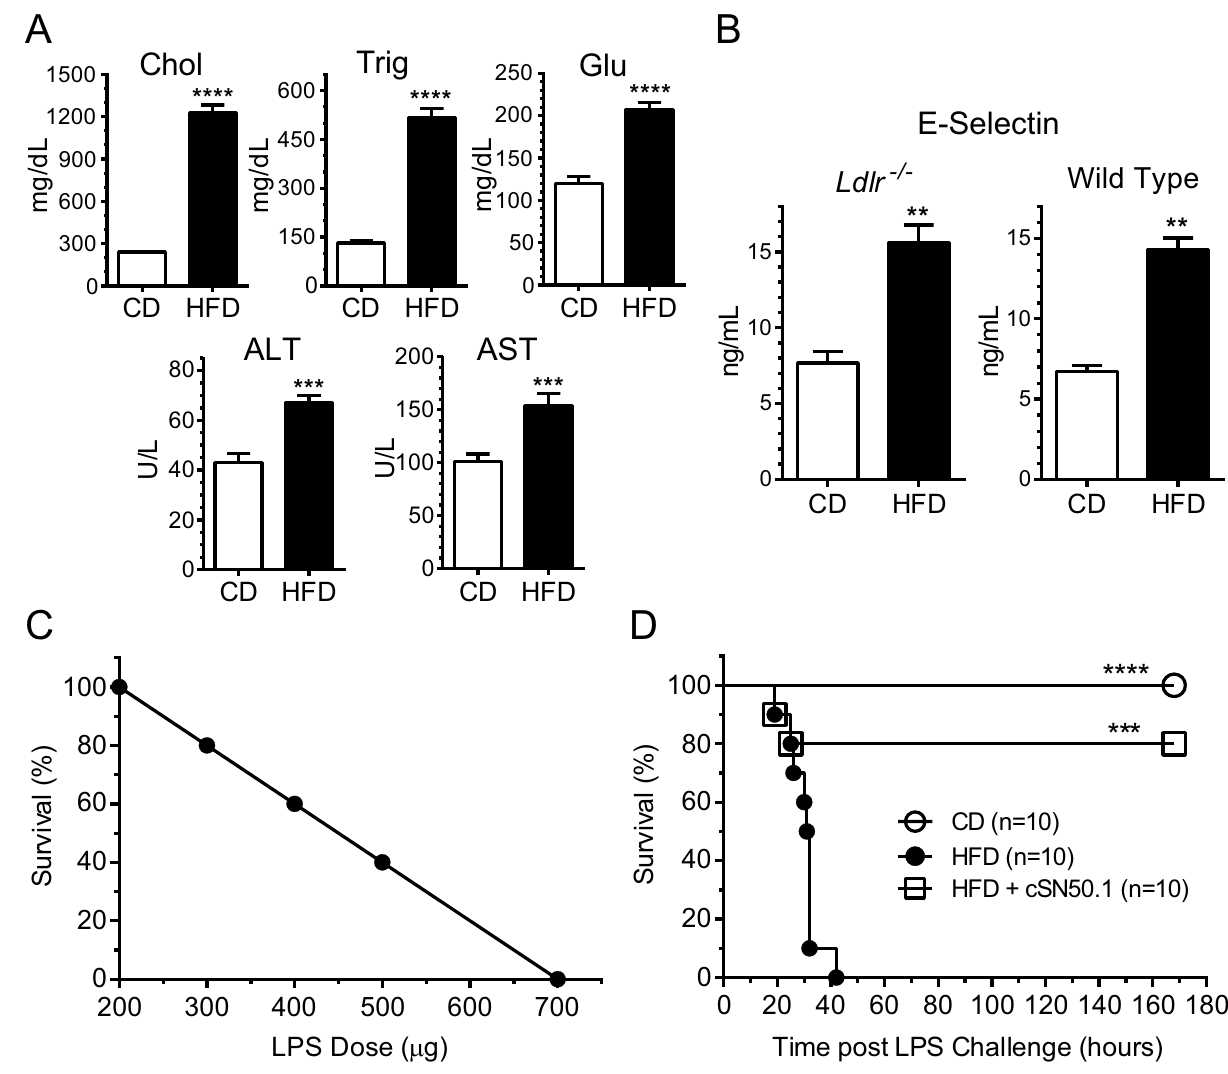
Figure 1. HFD-induced hyperlipidemia and hyperglycemia contribute to microvascular endothelial injury and hypersensitivity to LPS. ( A , B ) Elevated blood cholesterol (Chol), triglycerides (Trig), and glucose (Glu) as well as liver transaminases (ALT, AST) in 15-week-old ldlr −/− mice fed high-fat diet (HFD) for 3 weeks (tested group) or ldlr −/− mice fed chow diet (CD, control group). In panel ( B ), the effect of HFD on blood marker of microvascular endothelial injury, soluble E-Selectin, in 15-week-old ldlr −/− mice as compared to age- matched wild type, C57BL/6 mice. Both groups were fed HFD or CD for 3 weeks. ( A , B ) Data is presented as a mean ± SEM (n = 10). Statistical significance was determined by nonparametric t test with Mann–Whitney rank comparison, ** p < 0.005, *** p < 0.0005, **** p < 0.0001. ( C ) LPS-induced death of normolipidemic ldlr −/− mice is dose-dependent. 15-week-old, chow diet-fed ldlr −/− female mice (approx. 20 g of weight; n = 10) received a single dose of LPS (200, 300, 400, 500, or 700 μg in 0.2 mL saline) administered IP and 1-week survival was recorded. The survival curve represents a linear correlation with dose of LPS (S = − 0.2 × D LPS + 140; r 2 = 1.00). ( D ) All hyperlipidemic ldlr −/− mice succumb to the non-lethal dose of LPS (200 μg) while chow diet-fed cohort survives. Short-term treatment with biselective NTM, cSN50.1 peptide, that targets nuclear import pathways of SRTFs and MTFs, resulted in improved survival (80%). 15-week-old ldlr −/− female mice (n = 10/group) fed chow diet (CD), fed HFD, and fed HFD and treated with biselective NTM, cSN50.1 peptide (IP, 33 μg/g, 15 doses) given 30 min before LPS challenge (200 μg in 0.2 mL saline) and for three days thereafter. Survival was observed for 7 days. Data is presented as Kaplan–Meier survival plot with p value calculated by log rank analysis, *** p < 0.0005, **** p <